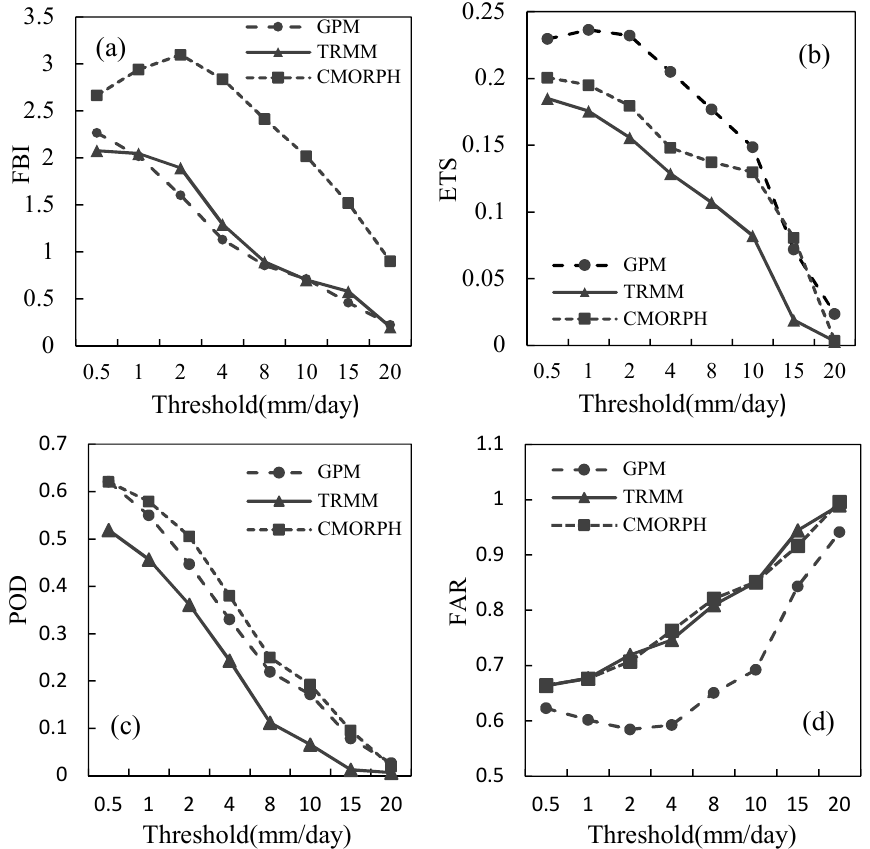
Figure 7. ( a ) frequency bias index (FBI), ( b ) equitable threat score (ETS), ( c ) probability of detection (POD), and ( d ) false alarm ratio (FAR) values for the different satellite-based